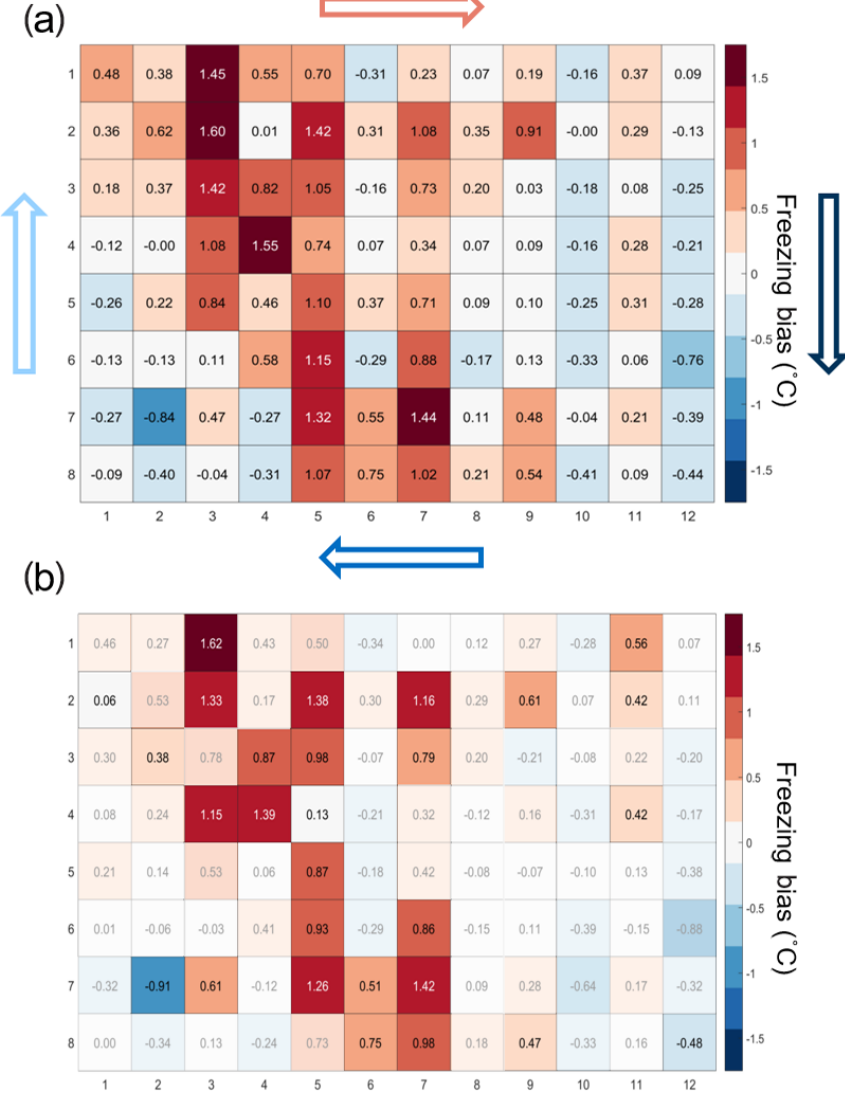
Figure 4. (a) Bias in the freezing of SA water ( (cid:101) w 4ref − (cid:101) w i in ◦ C) based on the median value of each well over 20 experiments relative to the median temperature of freezing for the four corner wells used during the temperature calibration. A positive (negative) bias indicates that the wells experience a warmer (colder) temperature than the four corner wells used for temperature calibration and therefore freeze at lower (higher) temperatures than reported. The arrows represent the ethanol circulation in the chiller, and the color represents the temperature trend of the ethanol as it circulates in the bath with, dark blue being the coldest and red the warmest. (b) Mean freezing bias of SA water between the four reference wells and each well ( w 4ref − w i ). Positive (negative) values indicate, as denoted by shades of red (blue), wells that systematically freeze at colder (warmer) temperatures and therefore experience warmer (colder) temperatures than reported. Statistically insignificant biases as determined by Welch’s t test (see Eq. A1) are depicted with white